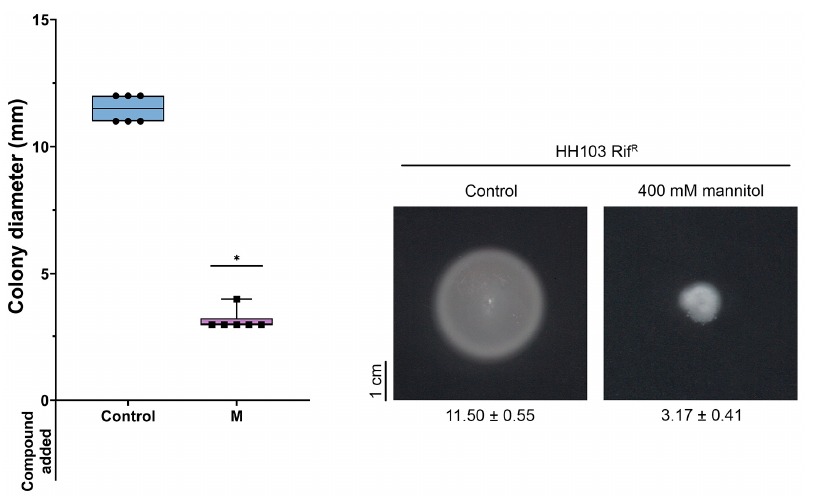
Figure 4. Swimming ability of S. fredii HH103 in Bromfield medium in the absence (Control) or presence of 400 mM mannitol (M). All data points are shown in box and whisker plots from at least three biological replicates performed with two technical replicates. Values under images represent the average and standard deviation of migration (given in millimetres and determined as described in the text). Asterisks (*) indicate a significant difference from the corresponding control sample using the non-parametric test of Mann–Whitney, α =